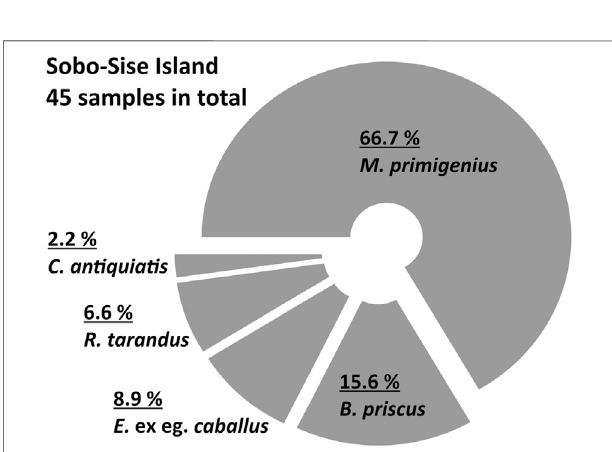
FIGURE 3 | Pollen diagram of the Sobo-Sise Yedoma record. For several taxa the concentrations (Conc.) are given (grain/g x1,000). AP - arboreal pollen, NAP - non-arboreal pollen, NPP - non-pollen palynomorphs.